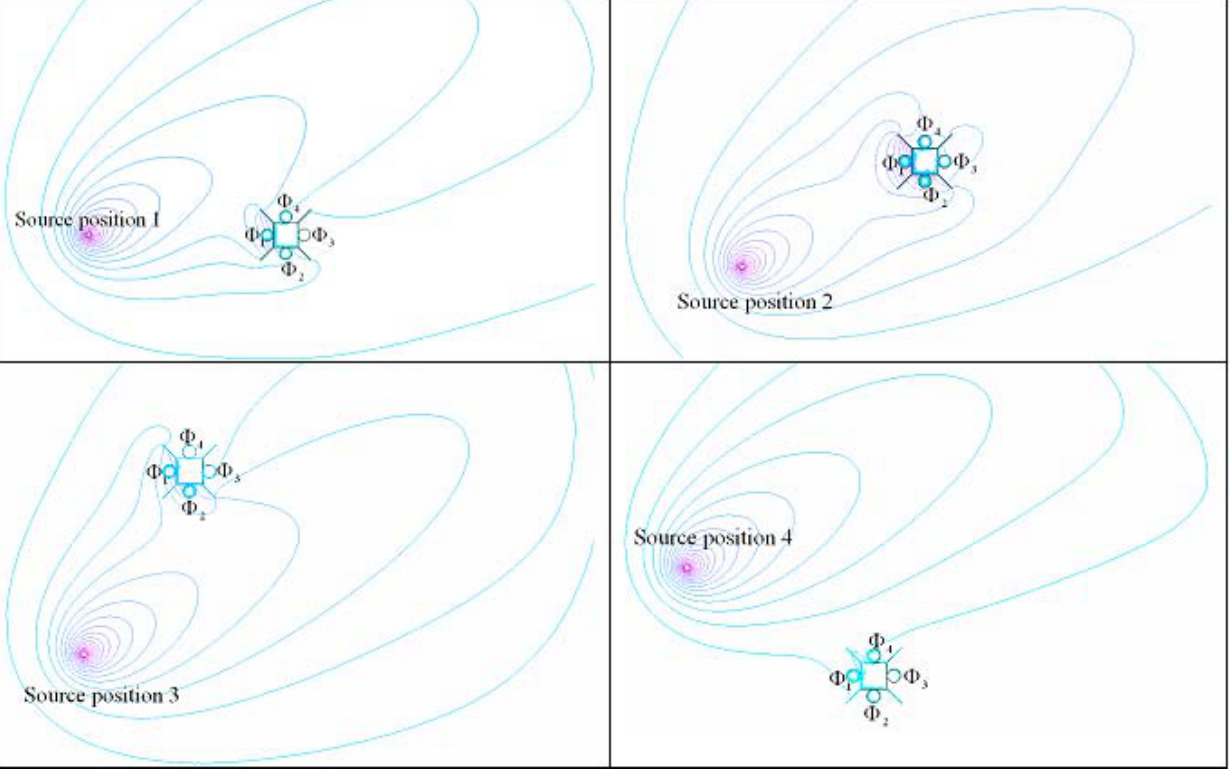
Φ with four different source positions in crosswind i